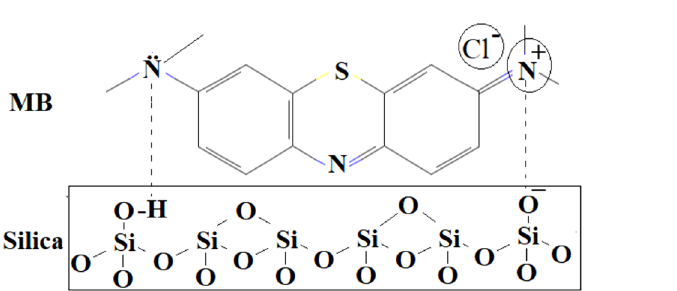
Figure 7. Adsorption capacity ( a ) and removal efficiency ( b ) of MB at initial concentration of 50 mg/L while using 50 mg of samples.